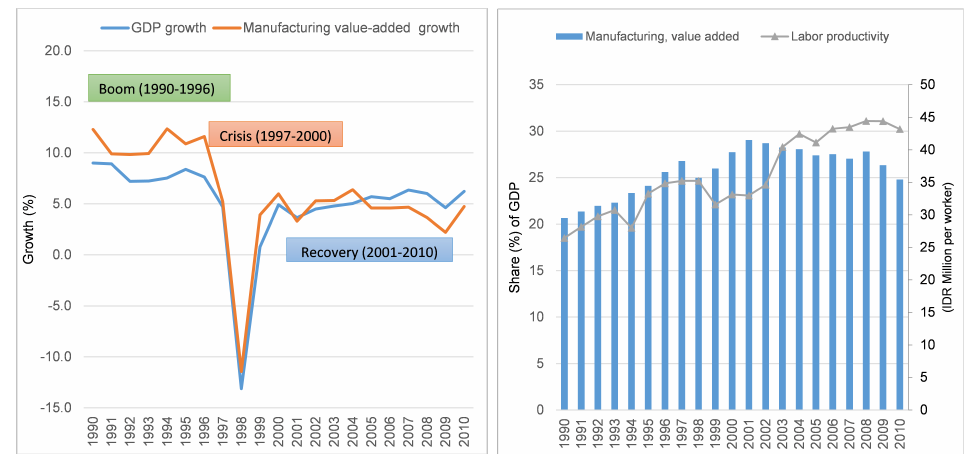
Figure 1: Indonesia’s Economic and Manufacturing Sector Growth: The Manufacturing Sector’s Contribution and Its